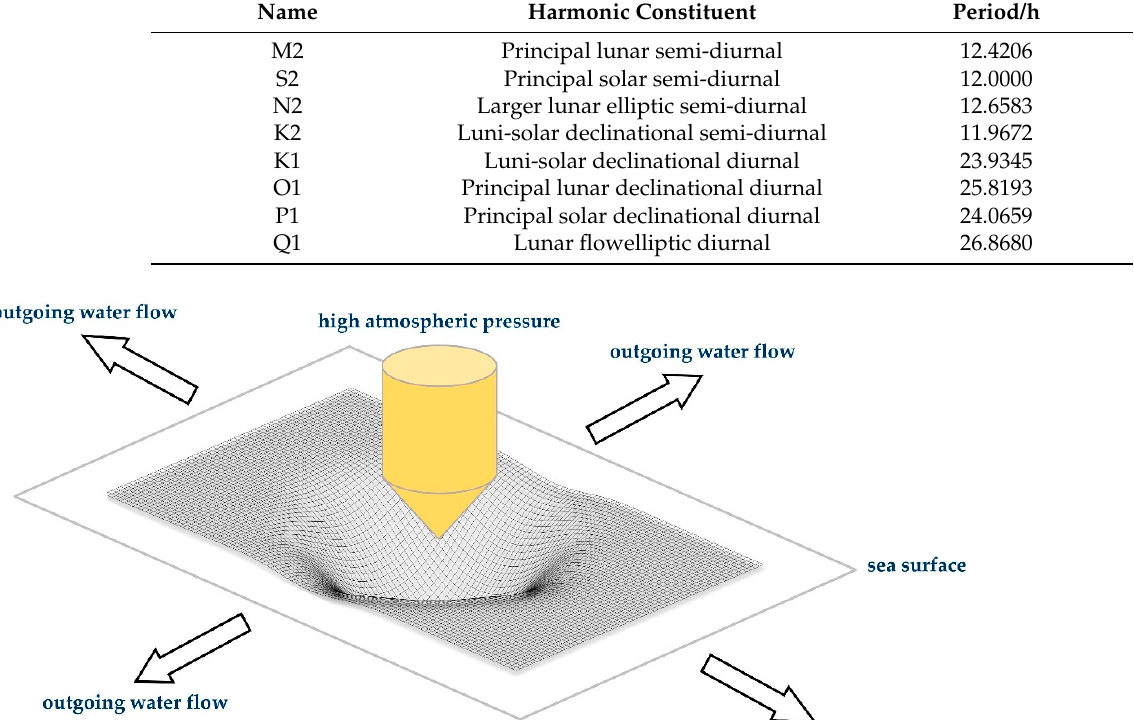
Table 1. The diurnal and semi-diurnal tide components and their periods expressed in hours (from [9]).